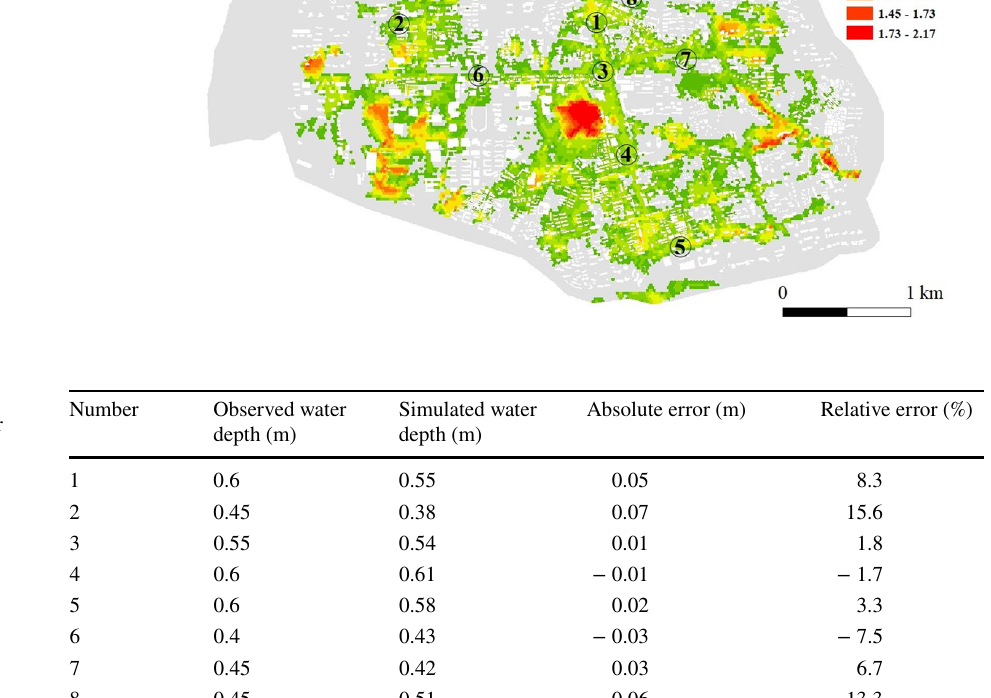
Fig. 7 Distribution of observed flooded points in the Haidian Island study area on Hainan Island, China